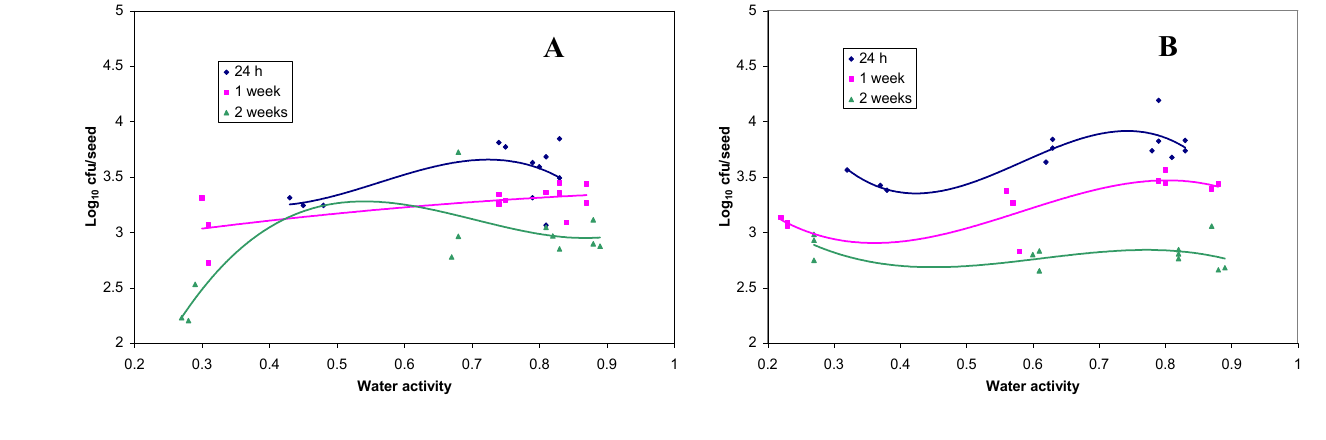
Figure 2. Viable number of Rhizobium leguminosarum bv. trifolii TA1 on seeds of Trifolium subterraneum ( A , B and C ) and Trifolium repens ( D and E ) relative to water activity after storage at different relative humidities. Peat cultures of rhizobia were applied to seed using different polyvinyl alcohol polymers, GL05 ( A and D ), GL05 + oil ( B ) and KL05 ( E ). In one experiment colonies were suspended directly from the surface of YMA in polyvinyl acetate latex ( C